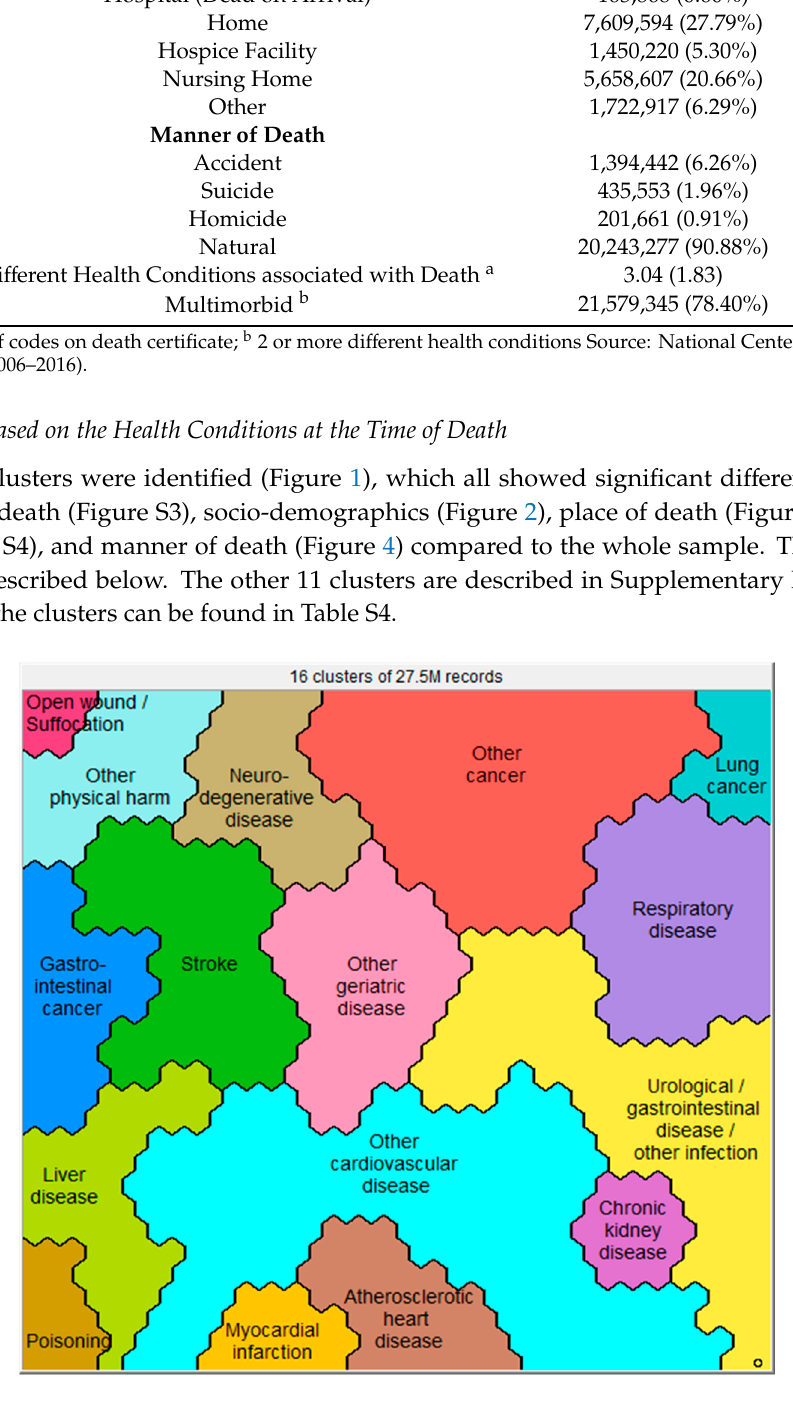
Figure 1. Sixteen clusters based on health conditions at death as reported in 27,525,663 death records. Subjects resembling each other in terms of these characteristics are close to each other on the map.